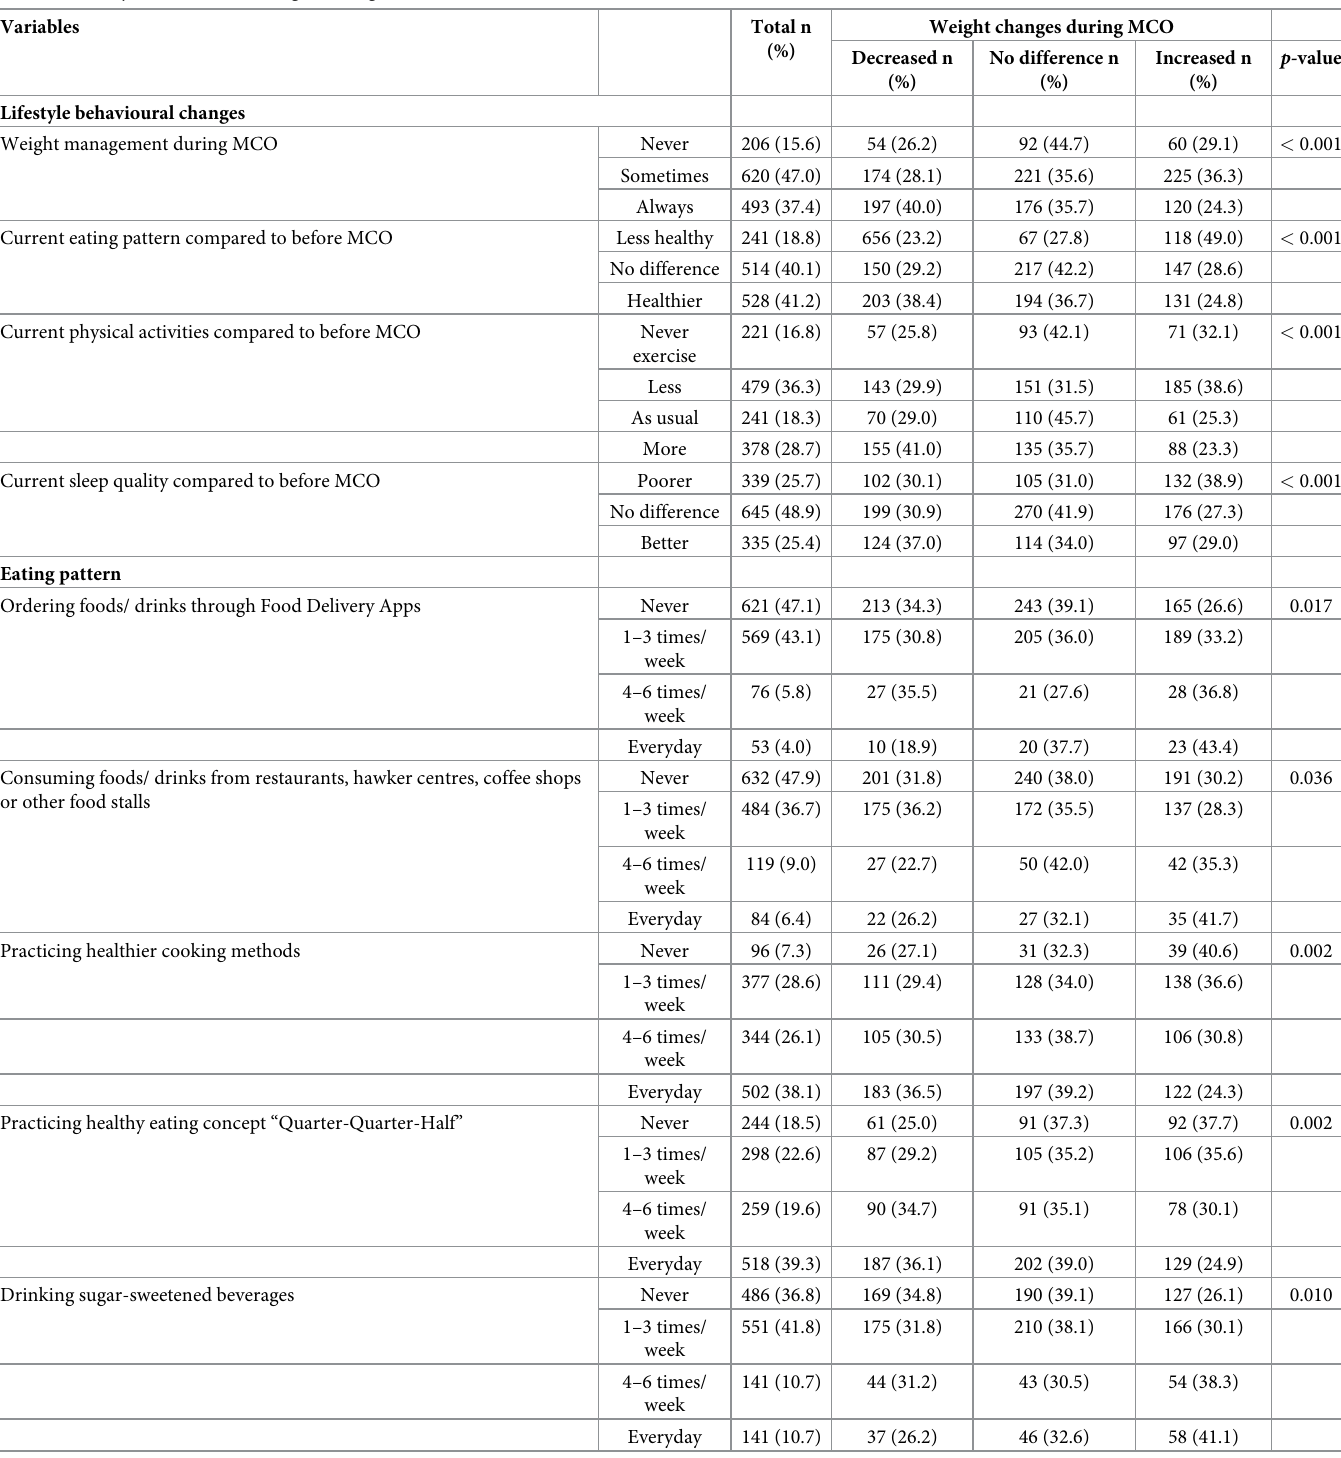
Table 3. Lifestyle behavioural changes during